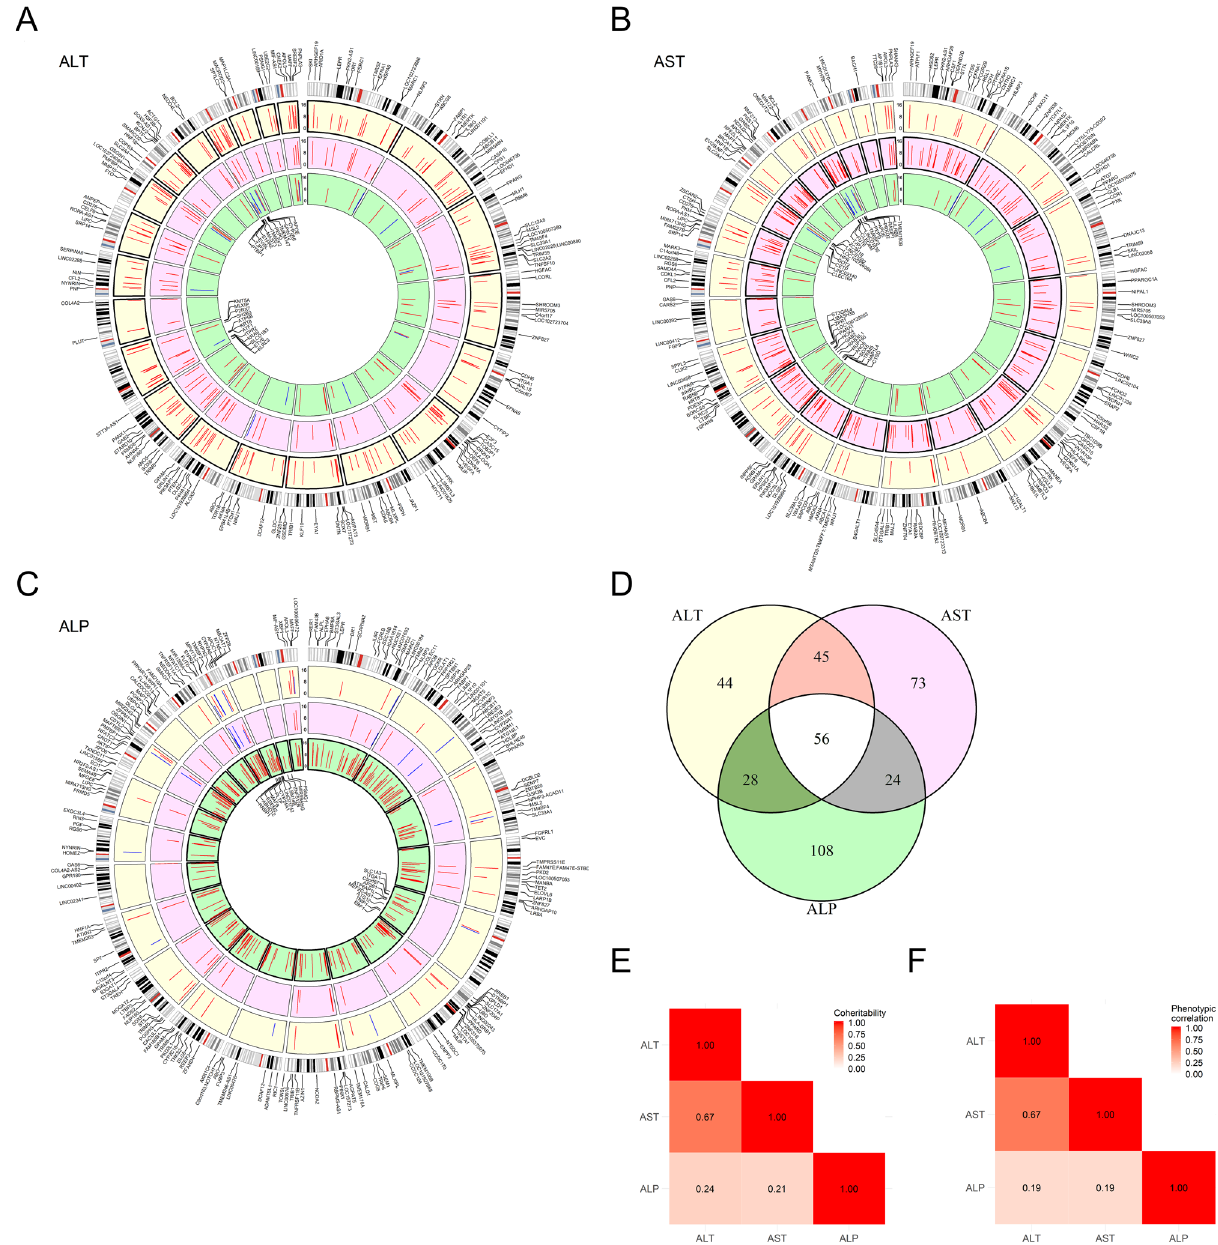
Fig. 2 Genetic loci associated with liver enzymes. A – C Circos plots depicting variants associated at genome-wide signi fi cance (unadjusted p < 5 × 10 − 8 ) with A alanine transaminase (ALT), B aspartate transaminase (AST), and C alkaline phosphatase (ALP), and the associations of these variants with liver enzymes. Height of the bar represents – log 10 p -value of association. Outermost circles represent associations with ALT, middle circles with AST, and innermost circles with ALP. Plots are aligned to the target liver enzyme, i.e. ALT in A , AST in B , and ALP in C , so that the alleles that increase the target liver enzyme are used. (Note that for this reason different sub- fi gures may depict different alleles of the same variant.) Red color indicates that the allele associated with higher target liver enzyme increases that speci fi c liver enzyme while blue indicates that that allele decreases the liver enzyme. Variants are labeled with their nearest gene or, for intergenic loci, the nearest upstream and downstream genes. p -values lower than 10 − 16 were rounded up to 10 − 16 for plotting purposes. A two-sided Z statistic was used to determine statistical signi fi cance. D overlap of loci across traits. E Co-heritability of ALT, AST, and ALP. F Phenotypic correlation of ALT, AST, and